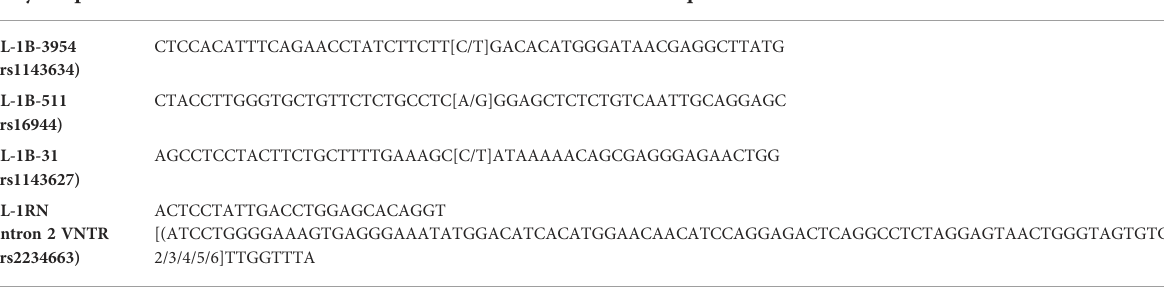
TABLE 1 The analyzed polymorphisms with the respective DNA sequences. Polymorphism DNA